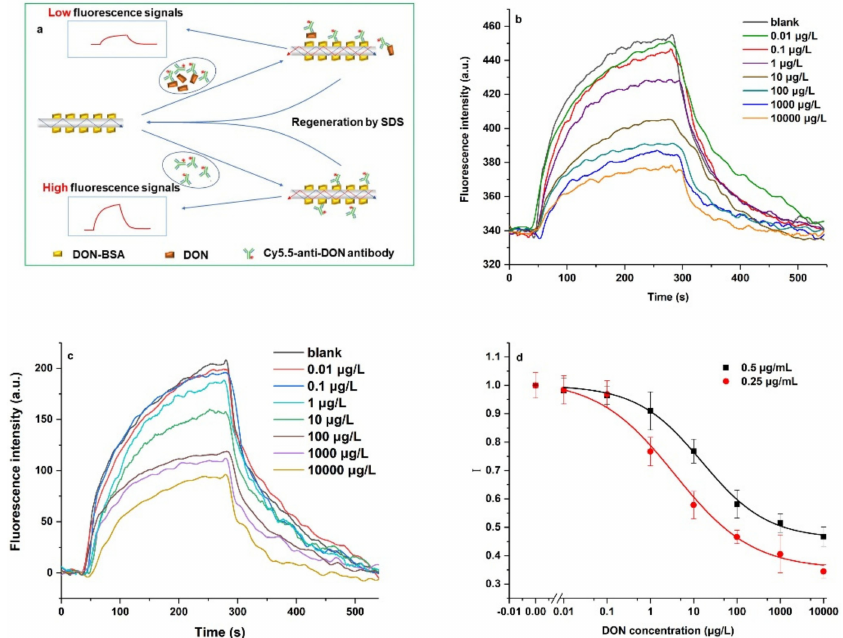
Figure 4. Detection of DON using the OIP-v2. ( a ) The indirect competition immunoassay mechanism of DON; ( b ) typical fluorescence signal traces with DON concentration ranging from 0 to 10,000 µ g/L using 0.25 µ g/mL Cy5.5-anti-DON-antibodies; ( c ) typical fluorescence signal traces with DON concentration ranging from 0 to 10,000 µ g/L using 0.5 µ g/mL Cy5.5-anti-DON-antibodies; and ( d ) the logistic-fitted dose-response curve for detection of DON. The error bars correspond to the standard deviation of the data points in the three repeated experiments ( n =